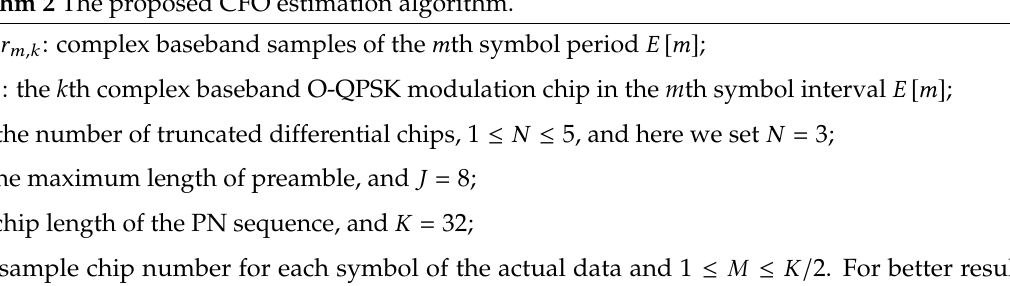
Figure 2. The structure of the quantization function G ( N ) . Algorithm 2 The proposed CFO estimation